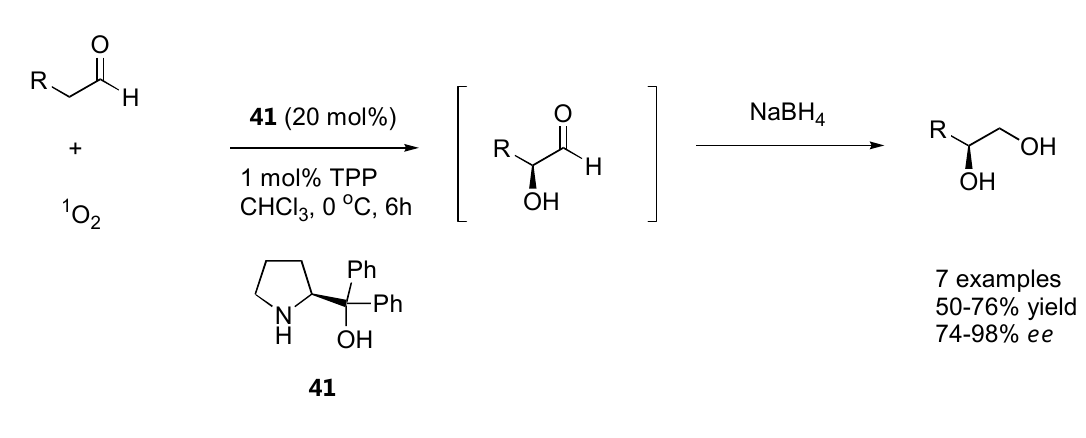
Figure 32. Organocatalyzed  -oxidation with molecular oxygen [125].